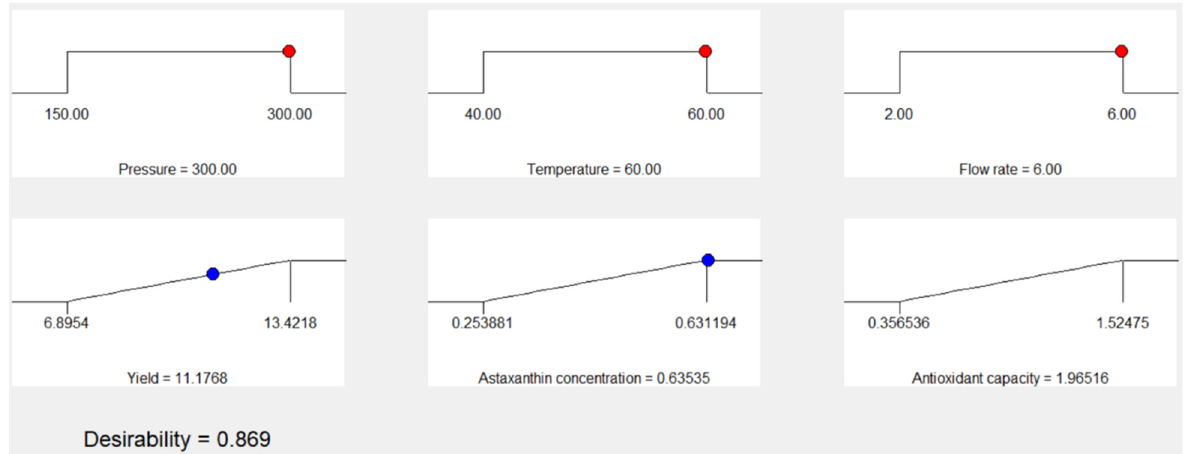
Figure 4. Response optimization of the effect of pressure, temperature, and flow rate for CO 2 supercritical extraction on extraction yield, antioxidant capacity (ABTS assay), and astaxanthin concentration of lyophilized liquor. Table 3. Astaxanthin concentration by HPLC and antioxidant capacity (ABTS and ORAC assays) of optimized undigested and digested supercritical CO 2 extracts of lyophilized liquor.